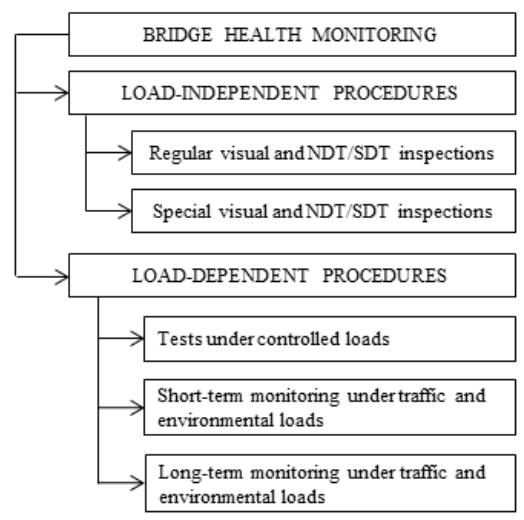
Figure 1: Basic procedures in Bridge Health Monitoring.